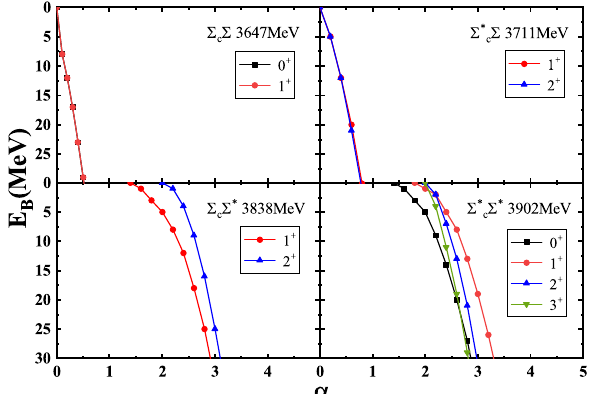
Fig. 3 Binding energies of isotensor bound states from the charmed- strange interactionswiththevariationof α insingle-channel calculation